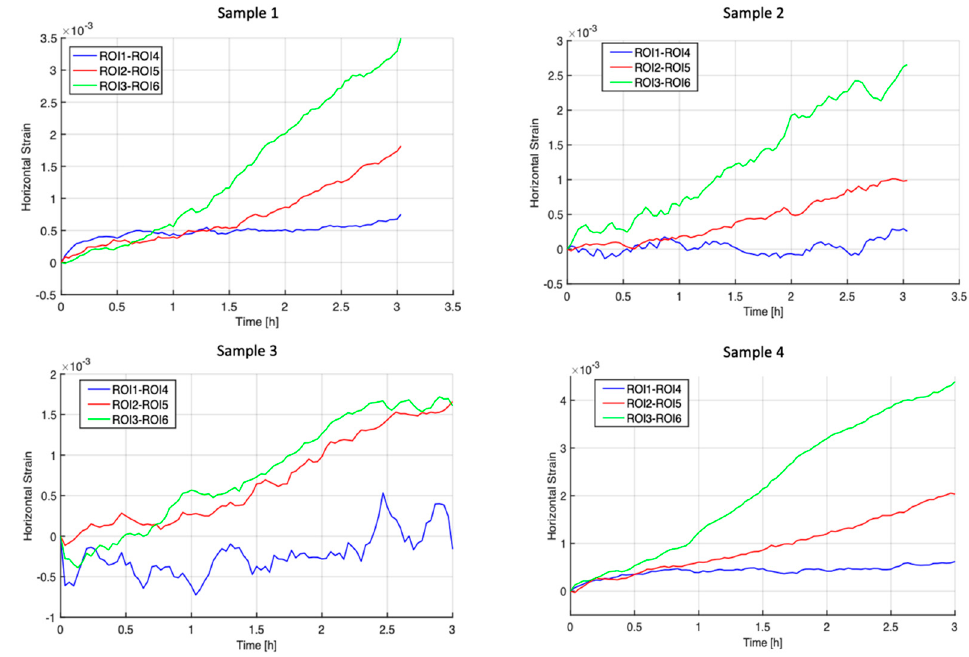
Figure 11. Measured horizontal strains for the four hydrated samples.